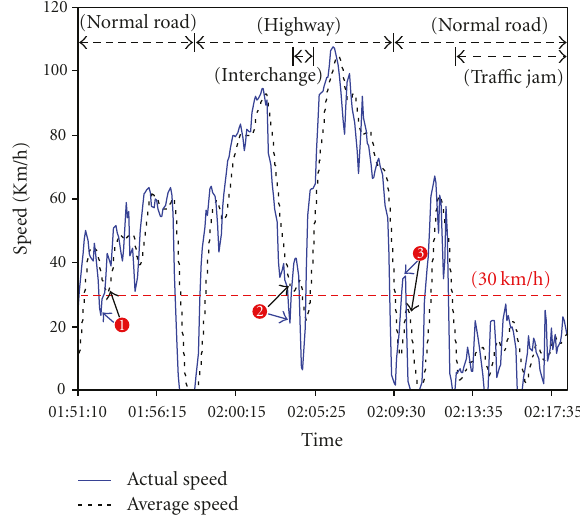
Figure 2: An empirical analysis of the threshold